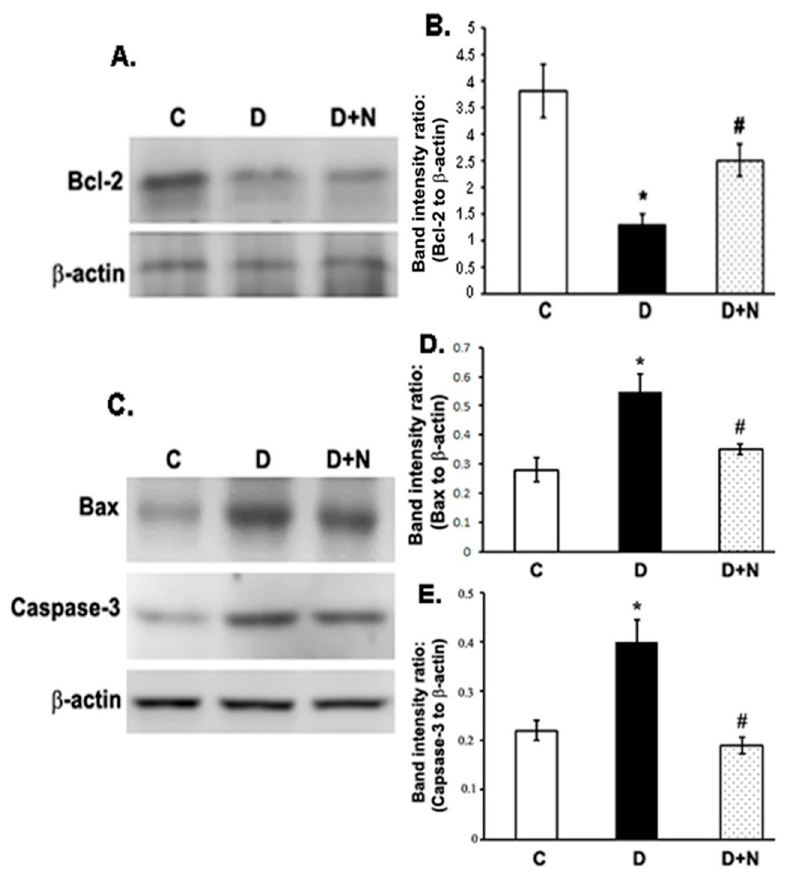
Figure 5. Western blot analysis of the expression of Bcl-2, Bax and caspase-3 in retinas from control, diabetic, and naringenin-treated diabetic rats. ( A ) Representative immunoblots of Bcl-2 and β -actin bands; ( C ) Representative immunoblots of Bax, caspase-3 and β -actin bands; ( B , D , E ) Data presented as ratios of those protein bands to β -actin. The intensities of the bands were quantified by densitometry. Values are means ± SEM; n = 6/group. * p < 0.01, significantly different from their controls; # p < 0.05, significantly different from diabetic. Bcl-2; B cell lymphoma 2. Bax; Bcl-2 associated X protein. C represents control, D as diabetic, and D + N as diabetic rats treated with naringenin.